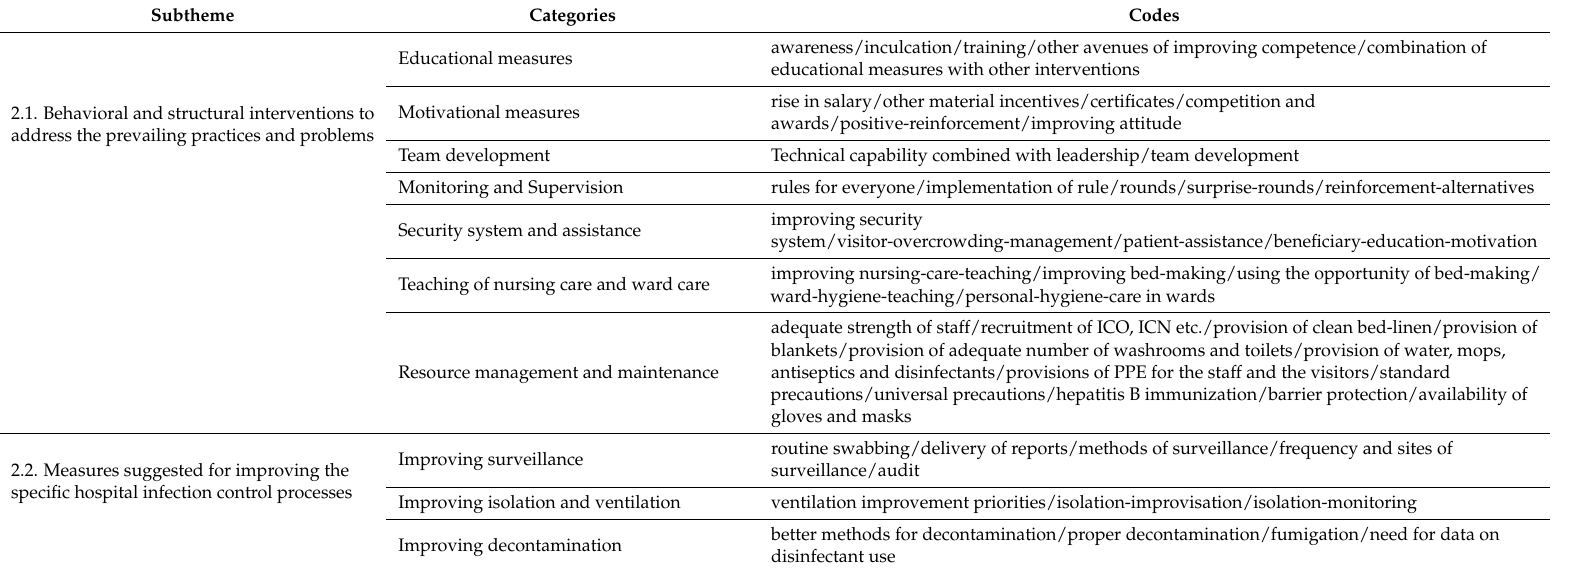
Table 3. Theme 2—Measures suggested for improving hospital cleanliness within the existing